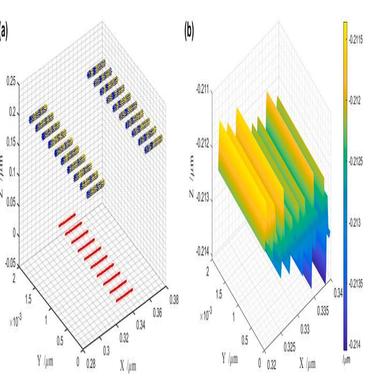
Data visualization in Experiment 3: (a) the fitting datum plane indicated by blue color; (b) false color plot of the bottom plane (in red in (a)) after subtracting the datum plane. (For interpretation of the references to color in this figure legend, the reader is referred to the Web version of this article.)